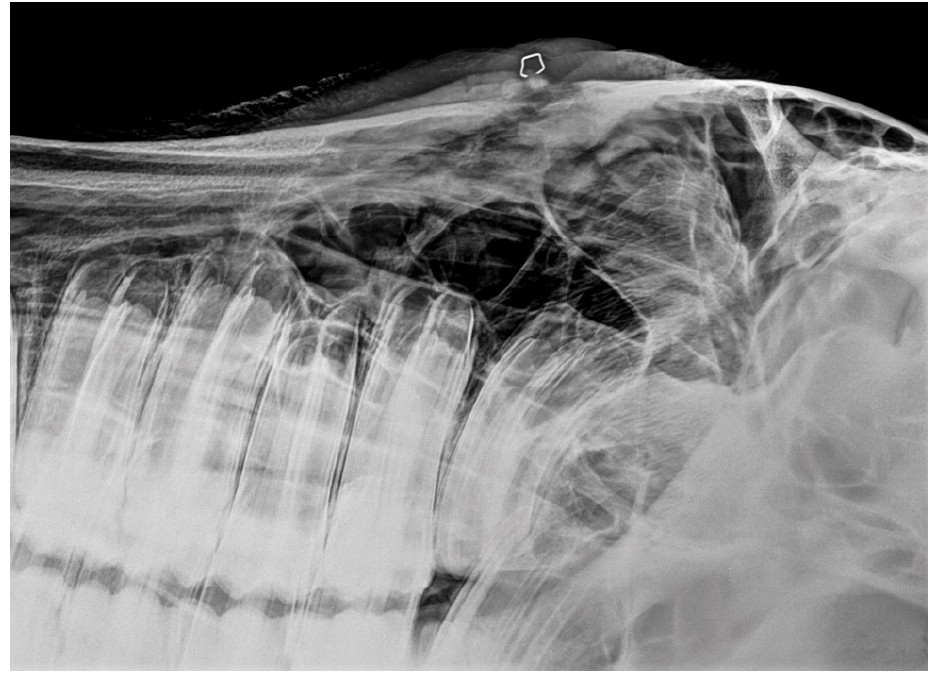
Figure 5. X-ray of a young horse with severe suture exostosis with sequester formation (metallic marker) and moderate soft tissue swelling.